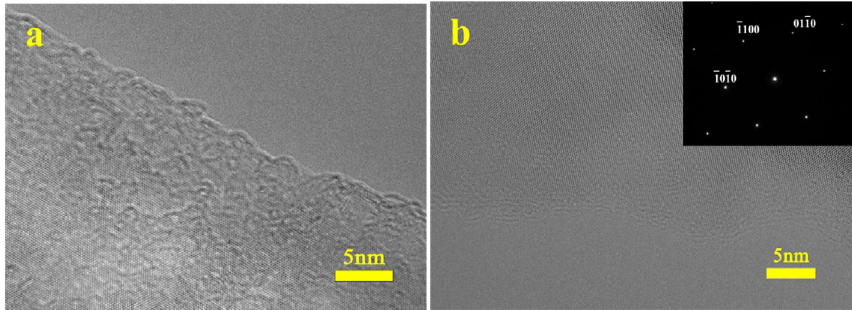
Fig. 4 High-resolution images of the BNs by (a) sonication and (b) hydrothermal reaction.